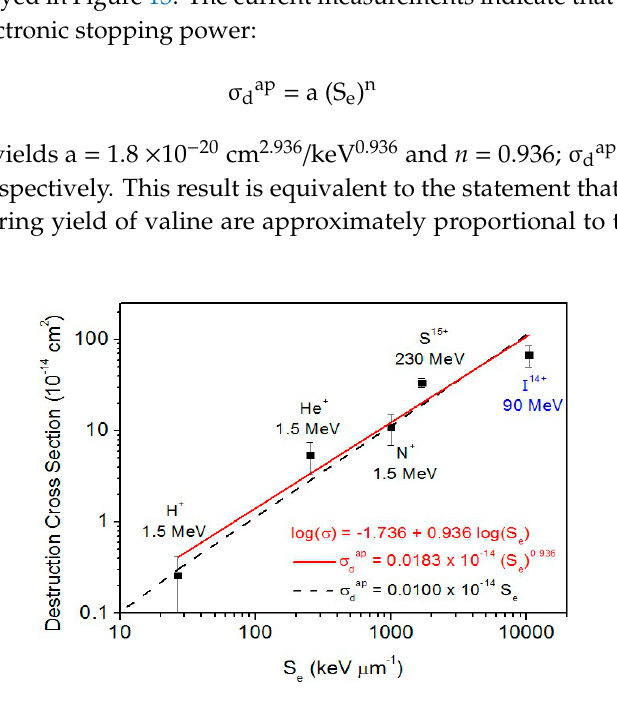
Figure 13. Dependence of the apparent destruction cross section on electronic stopping power. Dash line corresponds to σ dap proportional to S e . For the fitting parameters, σ dap and S e are expressed in cm 2 and keV/ μ m, respectively. 90 MeV 127 I projectile data were obtained with secondary ion mass spectrometry.